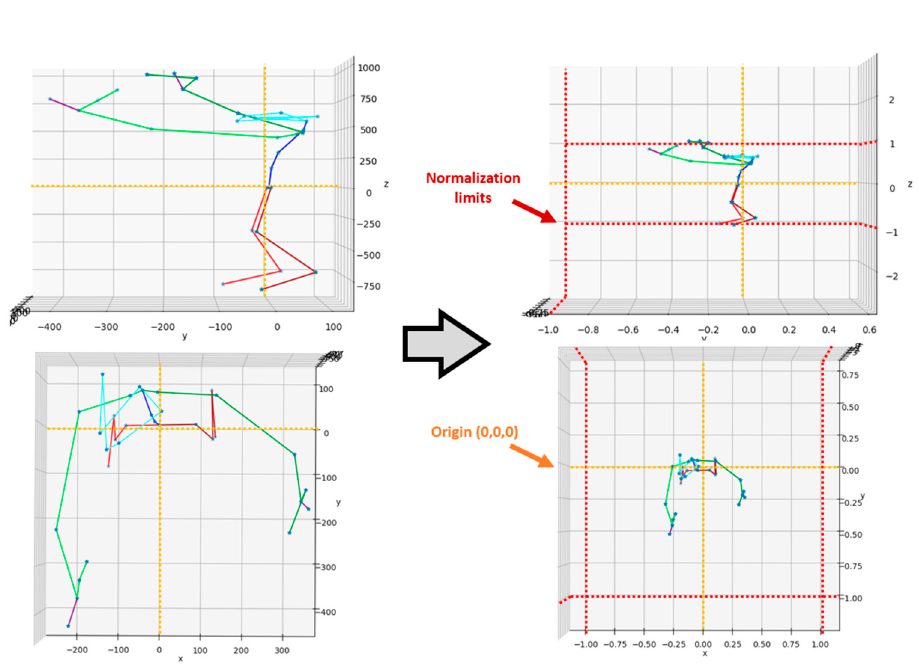
Figure 9. Step 5: Normalization of skeleton joint values between − 1 and +1 (scaling).